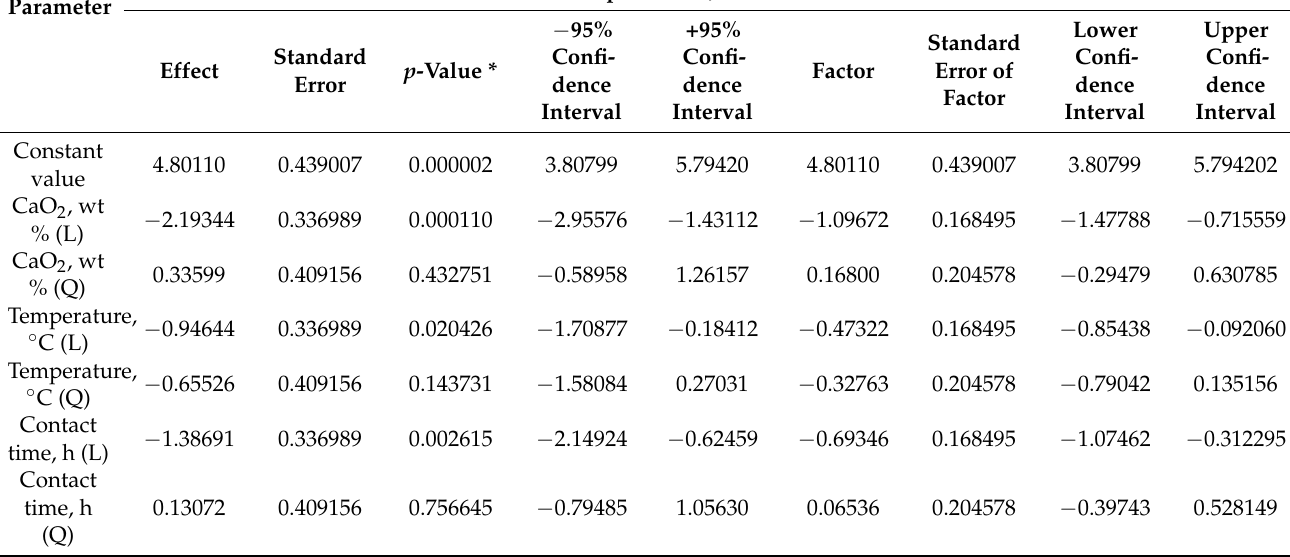
Table 3. Analysis of the inactivation E. coli model with CCD/RSM using ANOVA model